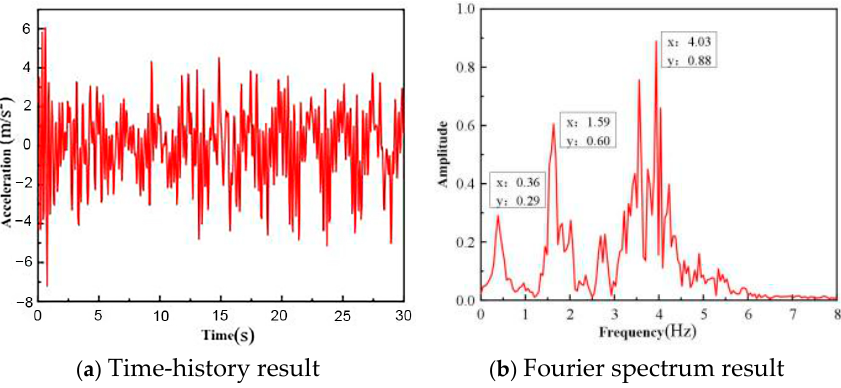
Figure 14. Crosswind acceleration response at monitoring point 1 under a windspeed of 6 m/s.